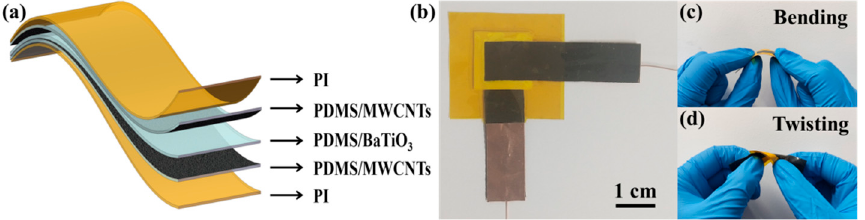
Figure 6. Sensor packaging. ( a ) Structure diagram; ( b ) sensor image; ( c ) the bending state of the sensor; ( d ) the twisting state of the